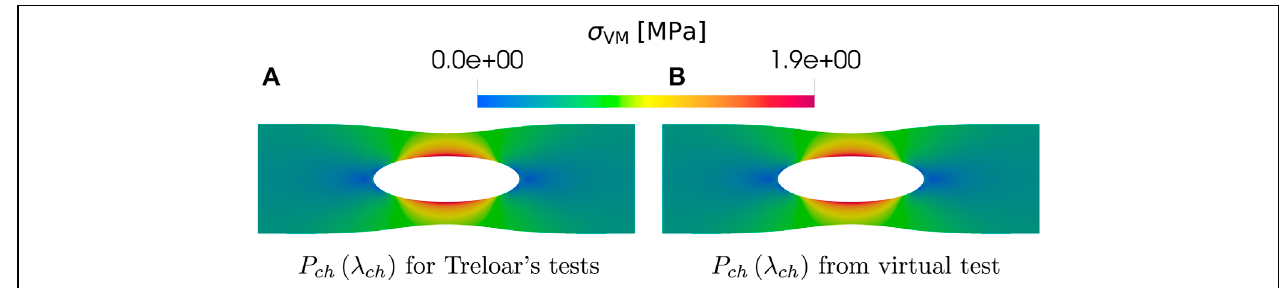
FIGURE 6 | Plot comparing the results of σ VM for the reference micro-mechanical model in Amores et al. (2020) that uses (Amores et al., 2020, Figure B.1) and the reverse-engineered one described in the article. (A) σ VM using the P ch ( λ ch ) obtained for unfilled rubber, Treloar (1944) extracted from (Amores et al., 2020, Figure B.1). (B) σ VM using the P ch ( λ ch ) reverse-engineered from the non-homogeneous virtual test using the methodology described in this article.